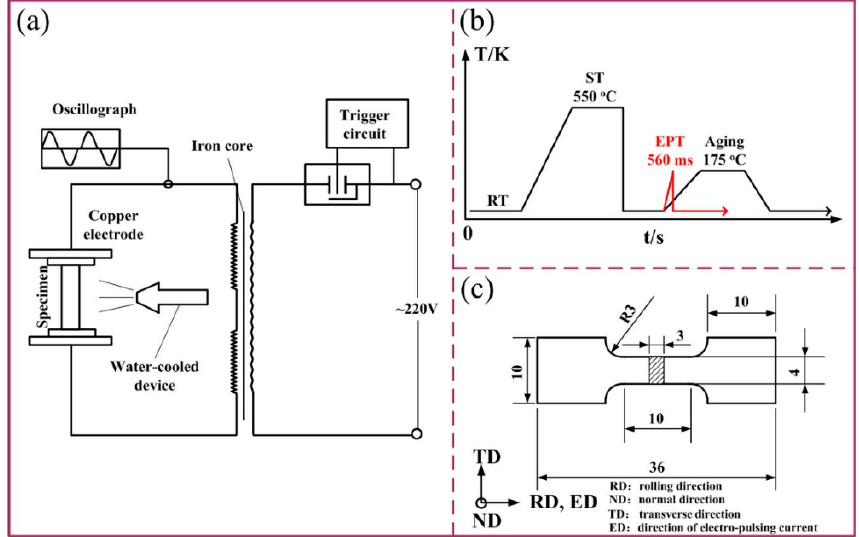
Figure 1. Schematic diagram showing ( a ) electro-pulsing machine, ( b ) treatment procedure, and ( c ) samples for tensile test.